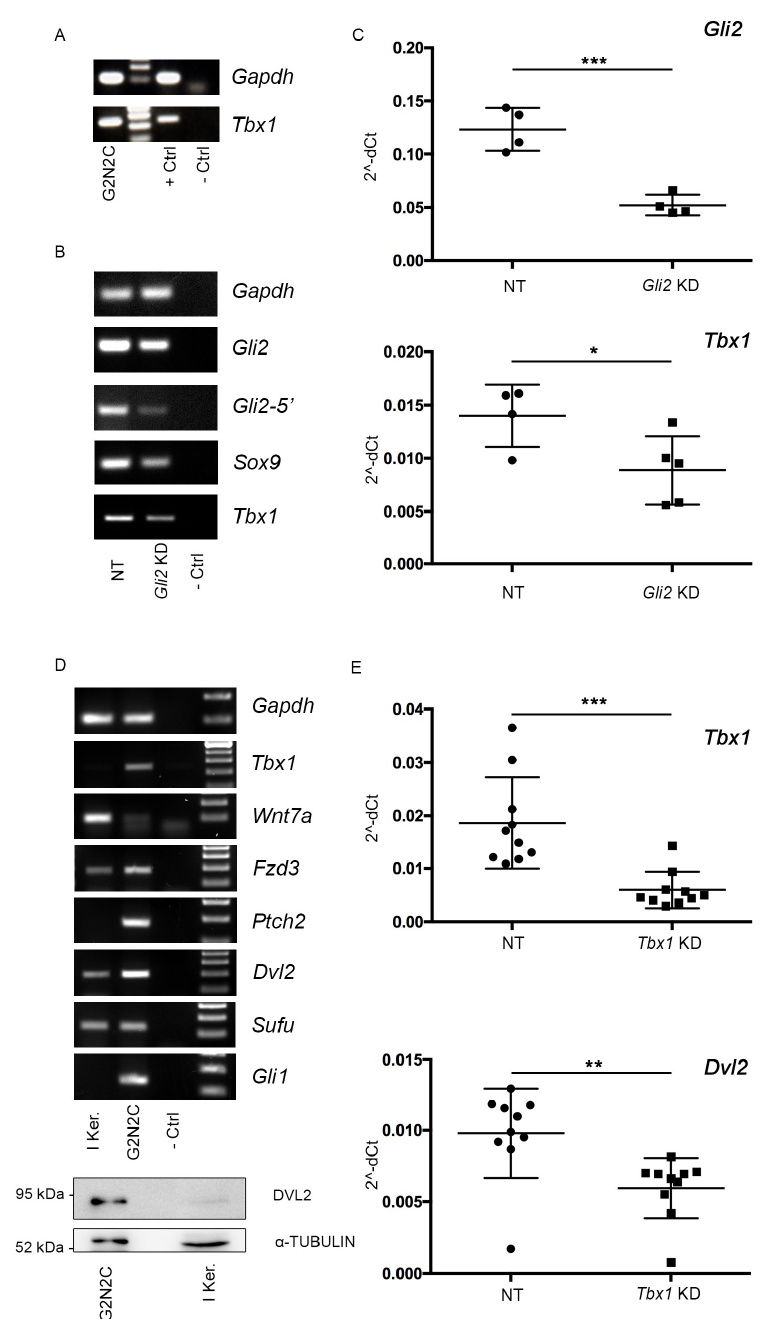
Figure 4. ( A ) Tbx1 expression in G2N2C cells assayed by reverse transcription (RT)-PCR. Positive and negative controls ( + Ctrl and – Ctrl) are cDNA from an E9.5 mouse embryo and from an RT sample, respectively. ( B ) Assay of the genes indicated in nontargeted (NT) and Gli2 -trageted short interfering RNA in G2N2C cells. ( C ) Summary of expression of Gli2 (top panel) and Tbx1 assayed by quantitative real time qRT-PCR in multiple experiments of Gli2 knock down in G2N2C cells. Each dot represents an independent experiment. ( D ) Expression of the genes indicated in primary keratinocytes and in G2N2C cells. Bottom panel: Western blotting analysis of total extracts from G2N2C cells and primary keratinocytes immunostained with an anti DVL2 antibody and with an anti-beta tubulin as loading control. ( E ) Summary of qRT-PCR experiments after Tbx1 knock down. The top panel shows the expression of Tbx1 , the bottom panel shows the expression of Dvl2 . * p < 0.05; ** p < 0.005; *** p <